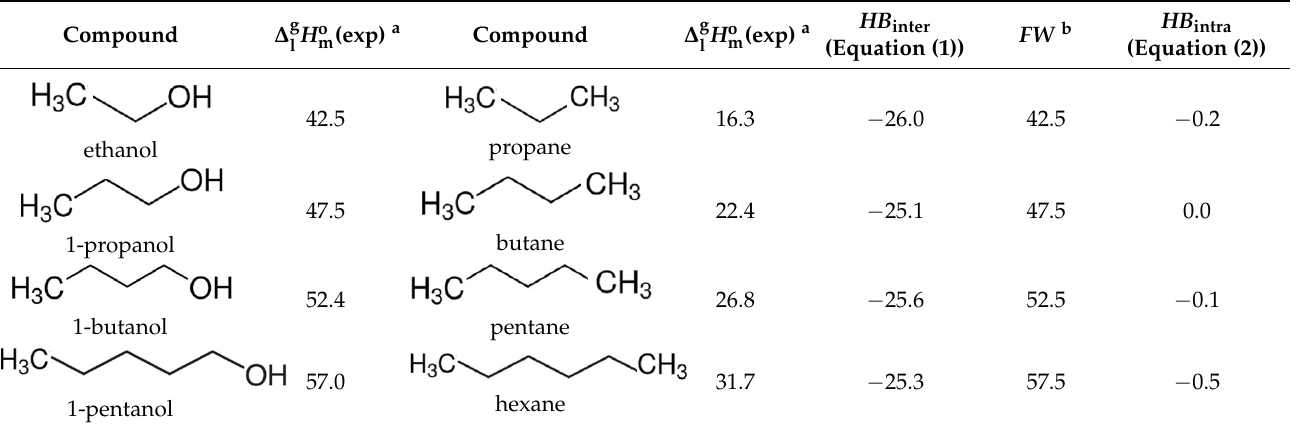
Table 1. Experimental enthalpies of vaporisation of alkanols and alkanes and the strength of inter- and intra-HB calculated from these values (at 298 K, in kJ mol −1 ). Compound ∆ g H o m (exp) a Compound l